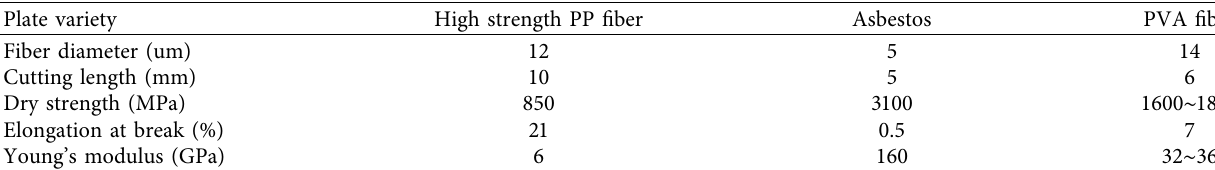
Table 3: Comparison of performance characteristics of different